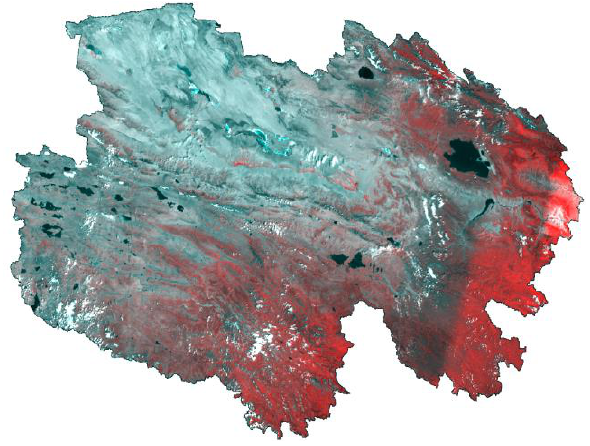
Figure 2. The mosaic image of study area after